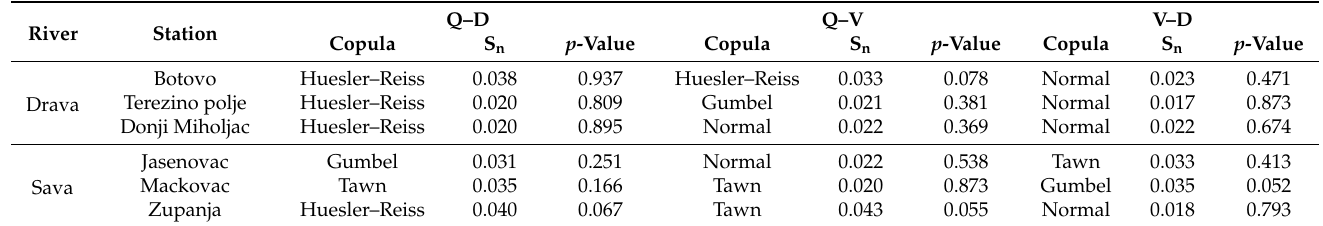
Table 9. Results of Cram é r–von Mises test for estimation of copula